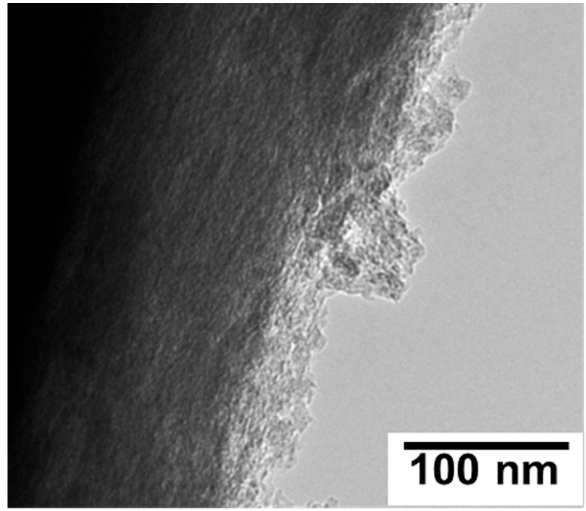
Figure 8. HR TEM image of the CNF-coated CMF